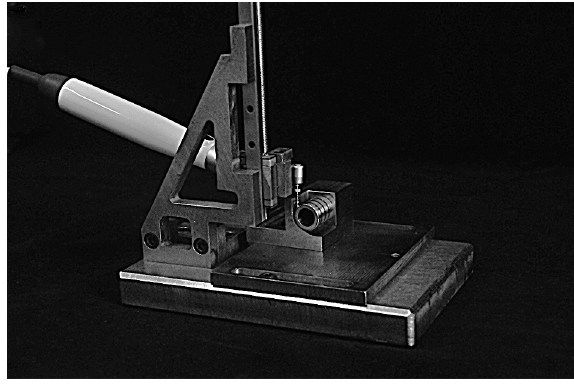
Figure 1. The apparatus with the file inserted into the artificial canals.